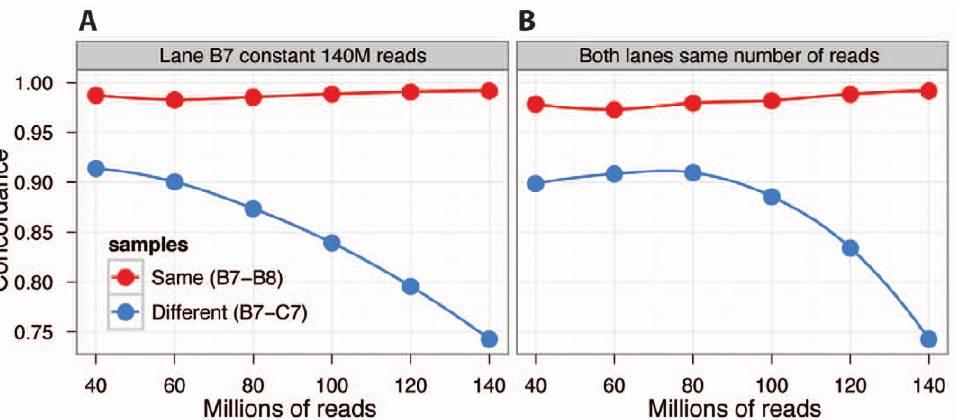
Figure 3. Effect of data quantity on concordance rates. The total number of reads used in the analysis affects different-sample comparisons, but not same-sample comparisons. In (A), lane 7 of sample ID B was kept constant at 140 million reads (B7), and the amount of data for the other sample [either lane 8 of B (B8) or lane 7 of C (C7)] was varied between 40 million and 140 million reads (x-axis) in 20 million read increments. The y- axis represents the concordance rate between variant (nonreference) genotypes called between the two different datasets. Note that for the same- sample comparison (red line), varying the number of reads used in the analysis does not substantially alter the concordance rate. However, this is not the case for different-sample comparisons (blue line), where the concordance rate becomes more different as more reads are used. In (B), a similar trend is observed when the reads in both samples are incremented simultaneously. Solid lines represent a LOESS smoothed fit to the data points.